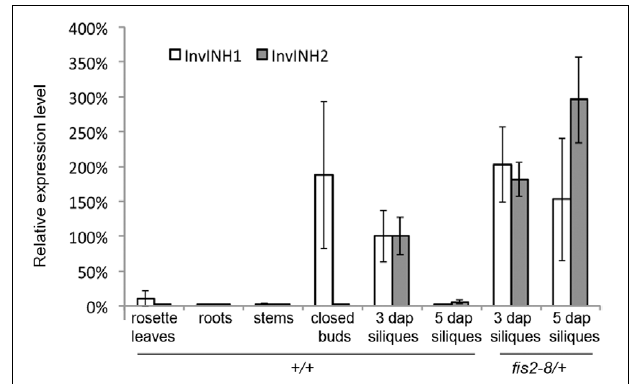
FIGURE 2 | The expression pattern of InvINH1 and InvINH2 in wild type (+/+) and fis2-8/ + mutant plants. The mRNA level of InvINH1 and InvINH2 was determined by qRT-PCR in rosette leaves, roots, stems, closed floral buds, and whole siliques at 3 and 5 dap. The expression level in wild-type 3-dap siliques was set as 100%, which was used as a reference point to calculate the relative expression level in other